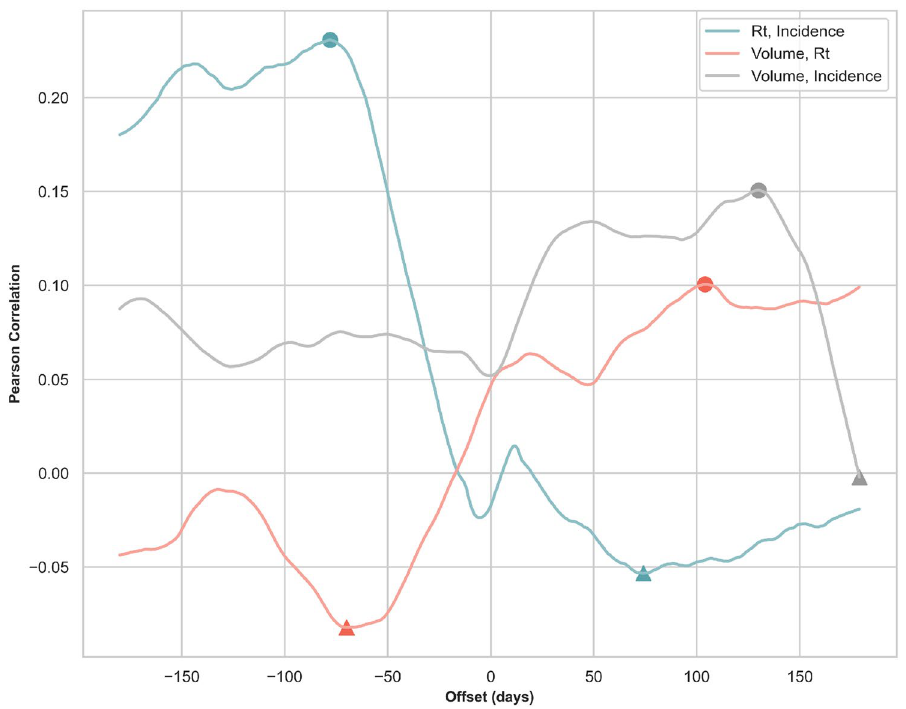
Figure 3. Time-lagged cross correlation (TLCC) among selected time series. This figure depicts TLCC among selected time series for an offset from − 180 to 180 days. The solid blue line shows the TLCC between the daily effective reproduction number and the daily reported incidence count. The solid red line shows the TLCC between the daily policy volume and the daily effective reproduction number. Finally, the solid gray line shows the TLCC between the daily policy volume and the daily incidence count. All calculations are averaged over the TLCC of each country from the first count until 31 Dec 2020. The filled circles and triangles indicate the peak correlations (the maximum positive correlation or the minimum negative correlation) between two series.